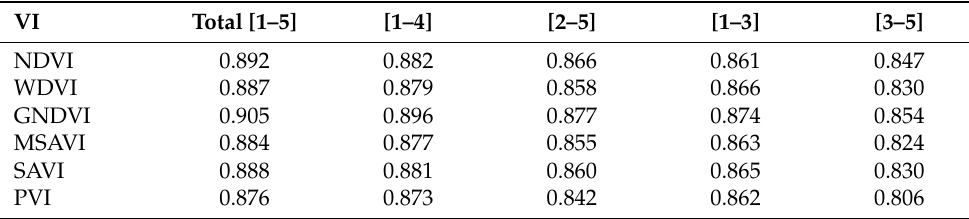
Table 17. The Pearson correlation coefficient between the different cumulative VI ranges and the recorded yield across all pilot fields.